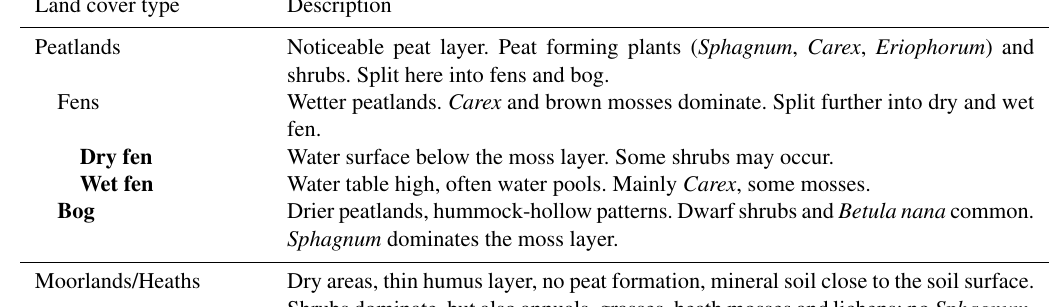
Table 1. Criteria used in the field to visually distinguish the land cover types of the study area (the final, applied types are in bold). Land cover type Description Peatlands Noticeable peat layer. Peat forming plants ( Sphagnum , Carex , Eriophorum ) and shrubs. Split here into fens and bog. Fens Wetter peatlands. Carex and brown mosses dominate. Split further into dry and wet fen. Dry fen Water surface below the moss layer. Some shrubs may occur. Wet fen Water table high, often water pools. Mainly Carex , some mosses. Bog Drier peatlands, hummock-hollow patterns. Dwarf shrubs and Betula nana common. Sphagnum dominates the moss layer. Moorlands/Heaths Dry areas, thin humus layer, no peat formation, mineral soil close to the soil surface. Shrubs dominate, but also annuals, grasses, heath mosses and lichens; no Sphagnum . Split here into tundra heaths and graminoid tundra. Tundra heaths Lichen or shrub dominated. Split further into lichen and shrub tundra. Lichen tundra Lichen dominated, but also a few dwarf shrubs, annuals and mosses; no Sphagnum . Often in patches surrounded by bare ground. Shrub tundra Shrub dominated, but also lichens, annuals and mosses; no Sphagnum . Graminoid tundra Grass dominated areas. Salix , shrubs, annuals and other vascular plants (e.g. Poly- trichum , Dicranum ) may occur. Meadows Riverside spring flooding areas, drier during growing season. Flood meadow Grass dominated, Salix common, annuals occur, brown mosses, no Sphagnum . Non-vegetated Bare soil Stony, non-vegetated